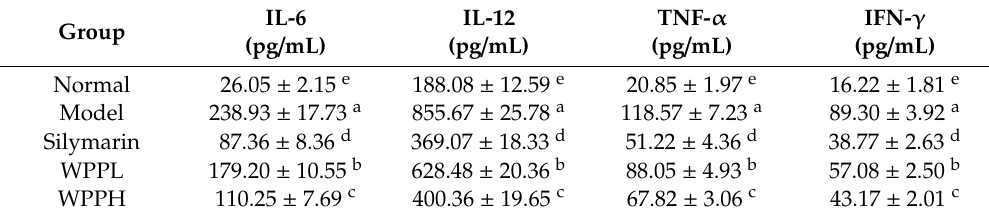
Table 5. Serum levels of IL-6, IL-12, TNF- α , and IFN- γ in mice ( N = 10).